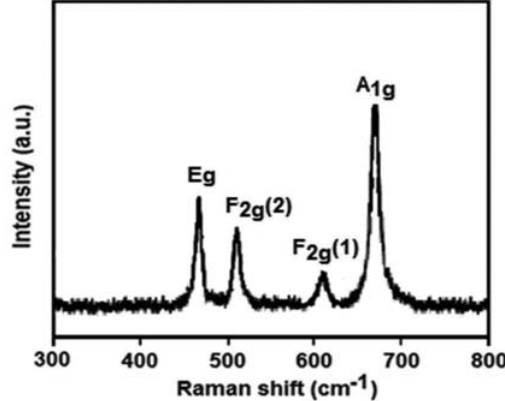
Figure 4. Raman spectrum of the Co